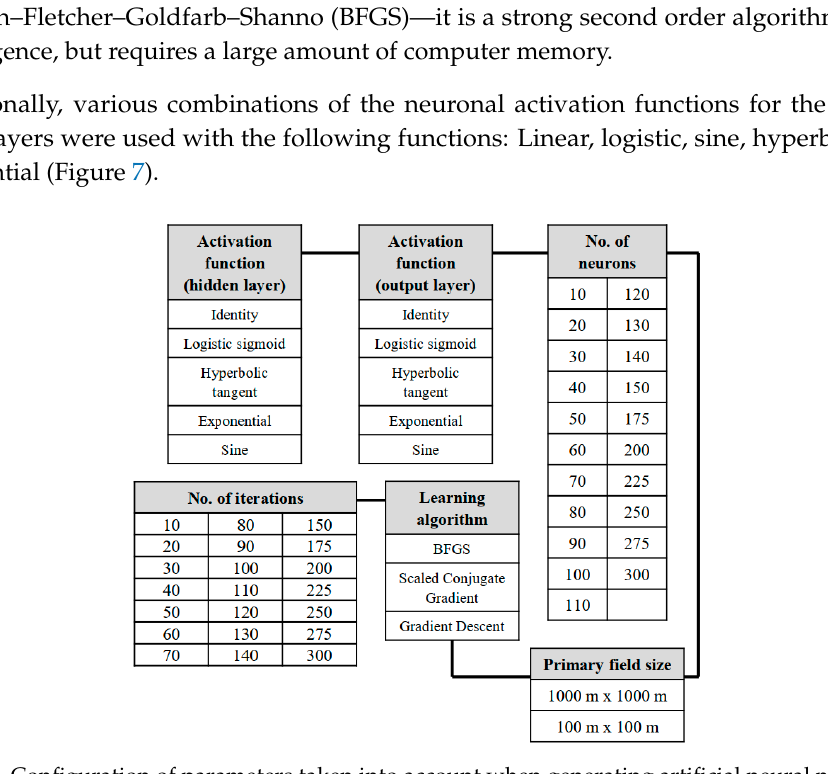
Figure 7. Configuration of parameters taken into account when generating artificial neural networks.